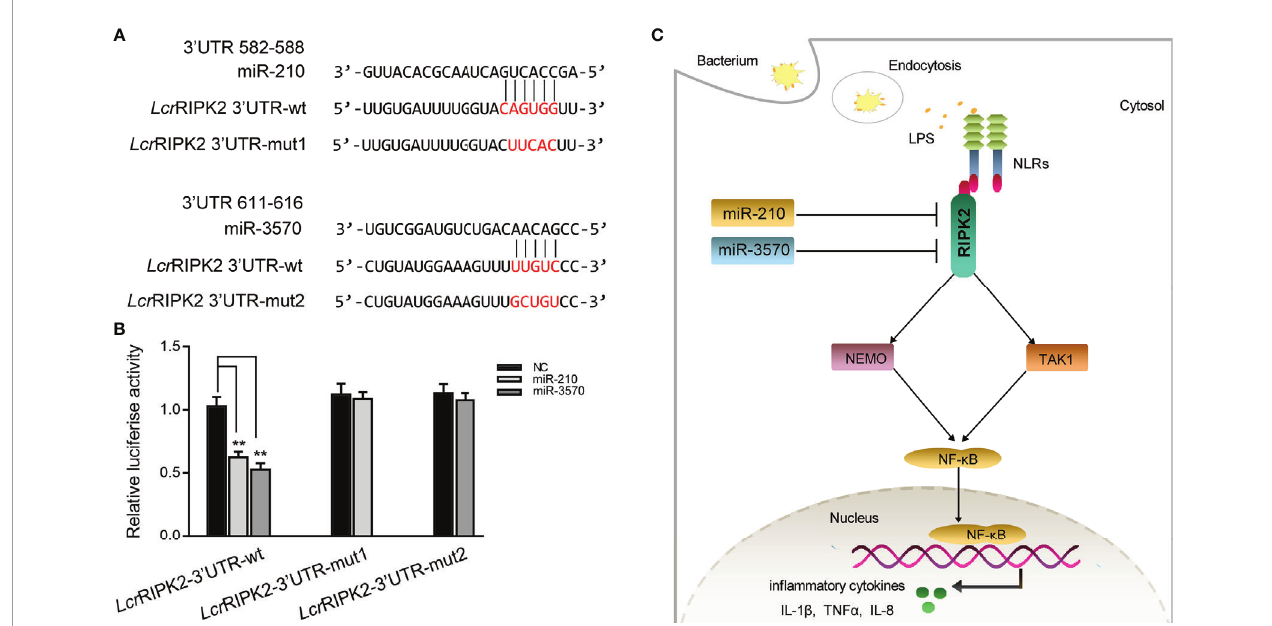
FIGURE 7 | Proposed model for the mechanism regulated by miR-210 and miR-3570 in fi sh species. (A) Schematic alignment of the predicted target sites of miR- 210 and miR-3570 in 3 ′ UTR of L. crocea RIPK2 ( Lcr RIPK2-3 ′ UTR wt). (B) EPC cells were transfected with miR-210, miR-3570 or NC along with the wild-type or mutant Lcr RIPK2-3 ′ UTR for 24 h and luciferase activity was determined. (C) The proposed model for the mechanism by which induced miR-210 and miR-3570 negatively regulate in fl ammatory cytokines production by targeting RIPK2 and inhibiting NF- k B signaling, thereby inhibiting excessive in fl ammatory response. All data are presented as the means ± SE from three independent triplicate experiments. **p < 0.01 versus the